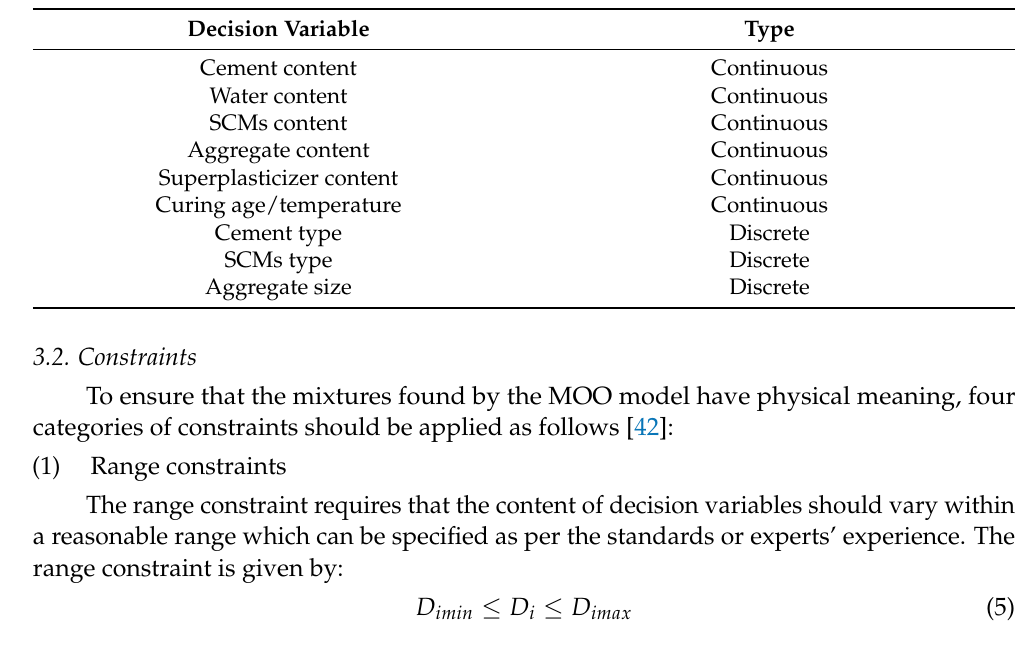
Table 1. Examples of decision variables for mixture optimization of cementitious